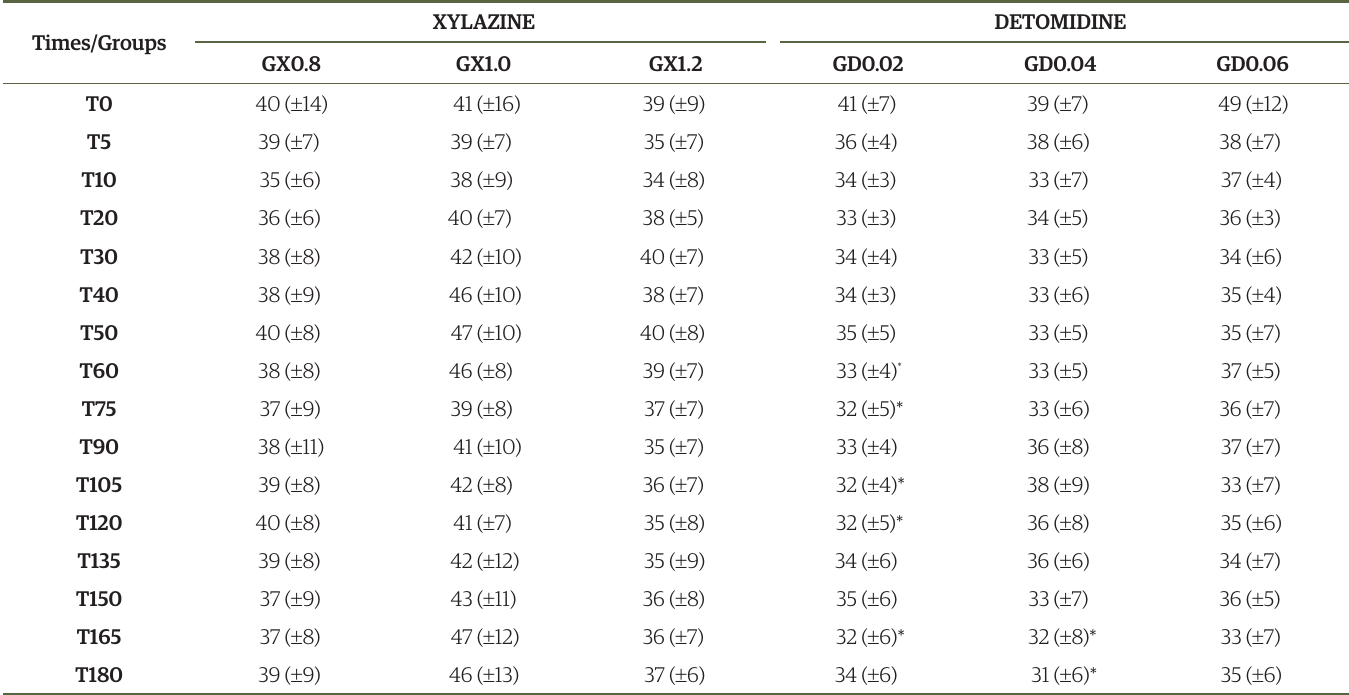
* = significant difference for the moment compared to T0